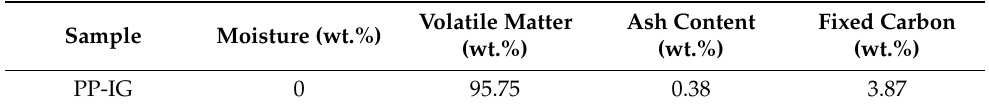
Table 2. Proximate analysis for raw PP-IG samples.